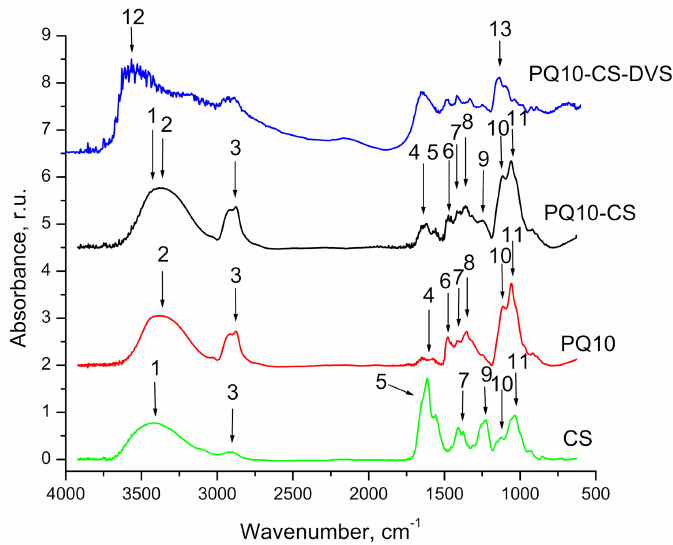
Figure 2. Infrared spectra of the crosslinked hydrogel compared with non-crosslinked gel and individual components taken as a reference. Numbers 1–11 means: 1: 3423, str. O–H and,